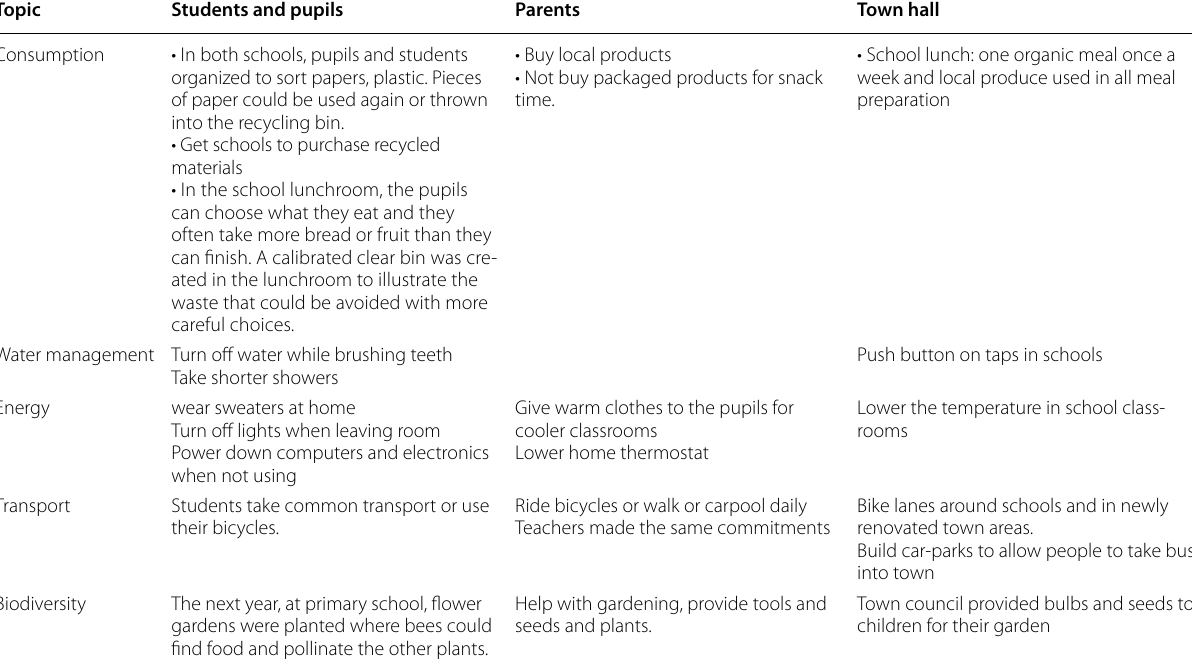
Table 4 Commitments to behavioral change by each group: students, parents, town officials Topic Students and pupils